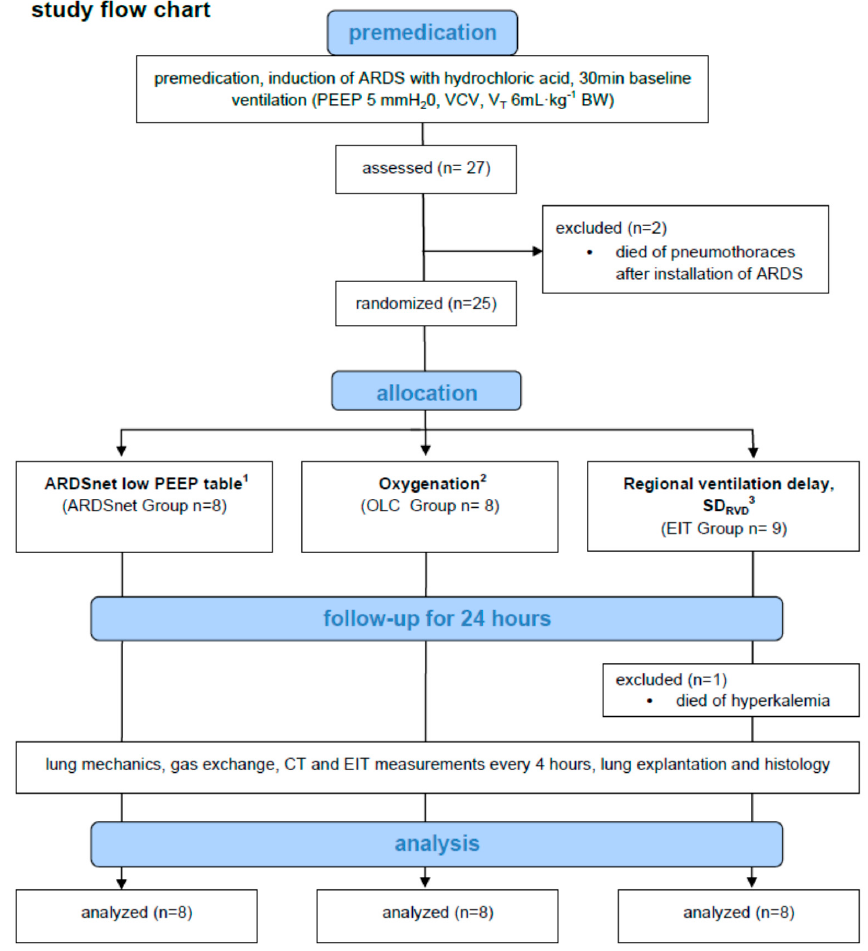
Figure 1. Study flow chart. Pigs were randomized after induction of Acute Respiratory Distress Syndrome (ARDS) and baseline ventilation with positive end-expiratory pressure (PEEP) of 5 mm H 2 0, volume-controlled ventilation (VCV) and tidal volume of 6 mL/kg bodyweight (BW) to one of three ventilation groups referred to in 1 [2] for ARDSnet low PEEP table, 2 [9] for Open Lung Concept (OLC) and 3 [23] for Electrical Impedance Tomography (EIT) with standard deviation of regional ventilation delay (SD RVD ) measurements. During the follow-up for 24 h computed tomography (CT) and EIT measurements were provided every 4 h. In the EIT group, one pig had to be excluded from the experiment because of intractable metabolic acidosis, thus, this experiment had to be repeated. As a result, 25 pigs were randomized. Because two pigs developed massive pneumothoraces after intra-tracheal hydrochloric acid instillation, we had to enroll 27 pigs in total (see Supplementary Materials). Pigs (weight 36.8 ± 5.0 kg) were fasted and premedicated with midazolam (1 mg·kg − 1 intramuscular) and ketamine (15 mg·kg − 1 intramuscular). Animals were anaesthetized by infusion of